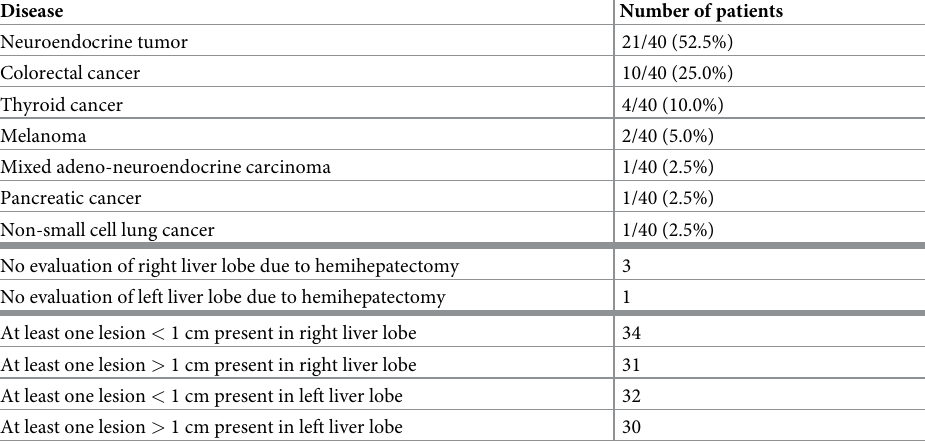
Table 2. Patient demographics and disease